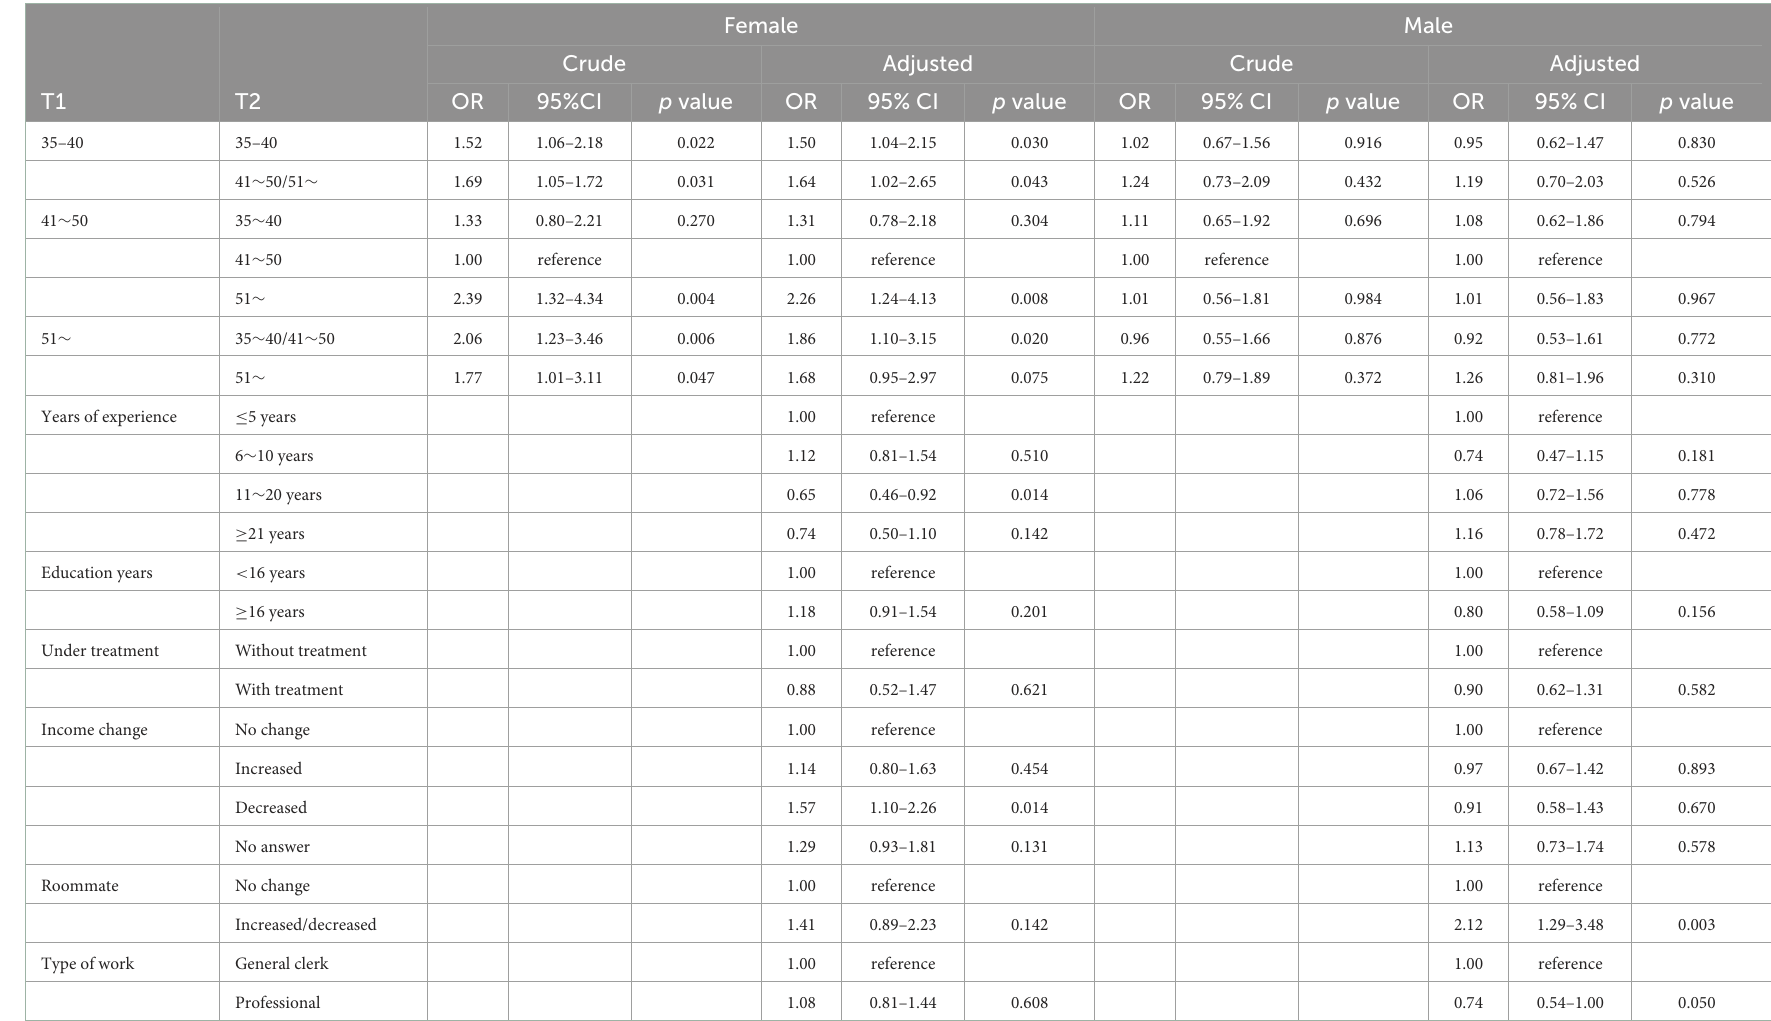
TABLE 4 Estimated odds ratios for high stress based on (B) psychological and physical stress responses category of the Brief Job Stress Questionnaire by